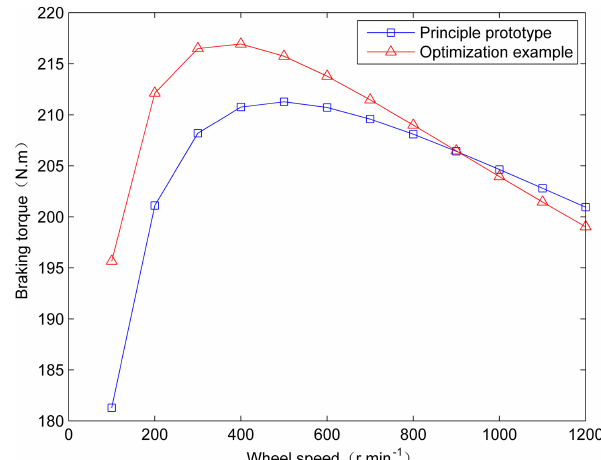
Figure 11. Correlation curves of the braking torque before and after the optimization